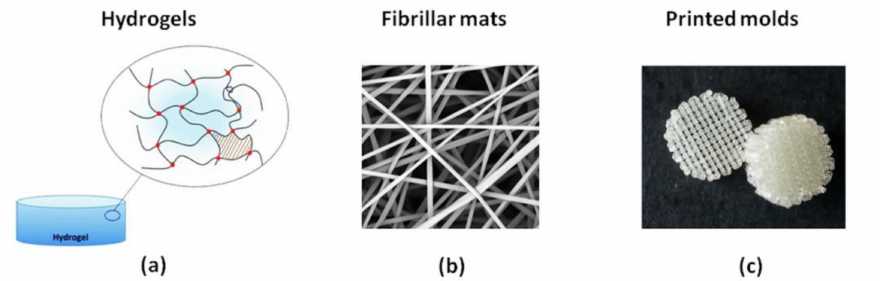
Figure 10. Different kinds of self-supported polymer materials obtained in the Laboratory of Nano- and Microstructural Materials: ( a ) hydrogels, ( b ) fibrillar mats, ( c ) printed molds.